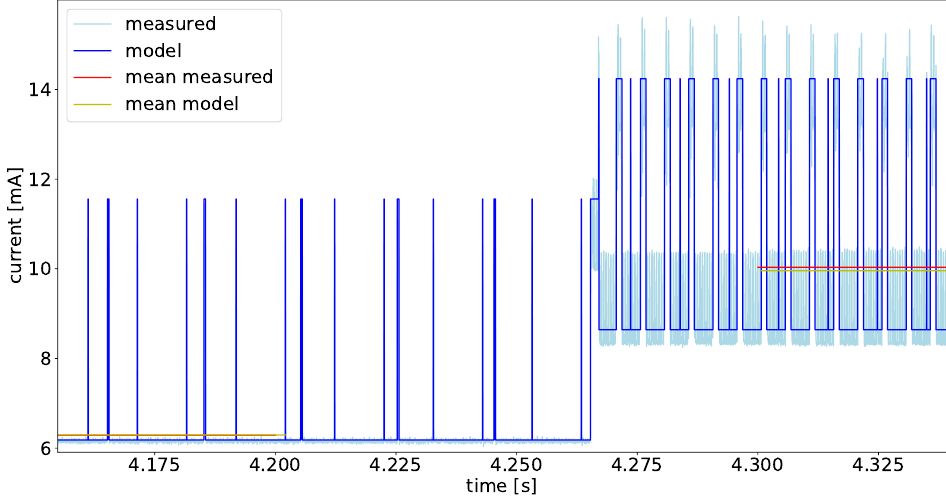
Figure 15. Zoomed view of the example test run in Figure